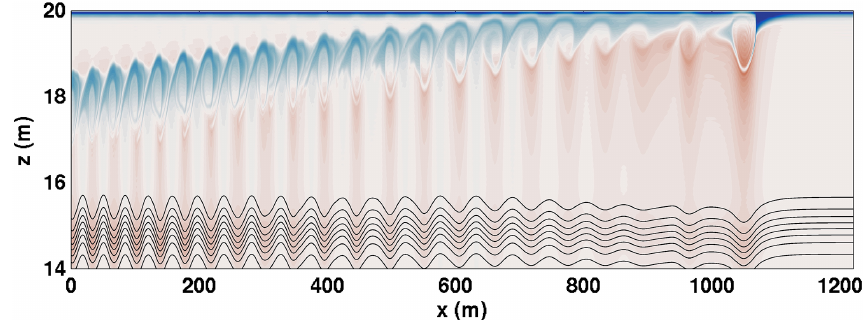
Figure 11. The relative vorticity field saturated at 0 . 1s − 1 for the CL2 case with the density field overlain at t =